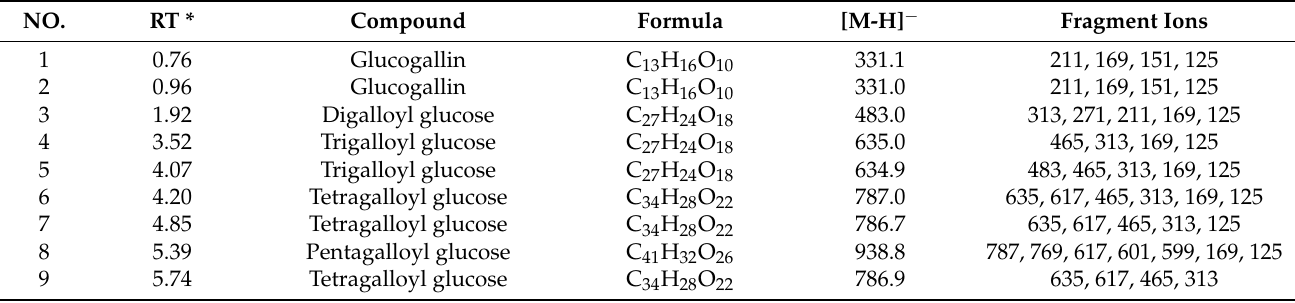
Figure 3. Molecular network of gallotannins in P. rockii and P. ostii based on NL–IDA–EPI scan. Table 1. Identified gallotannins in P. rockii and P. ostii